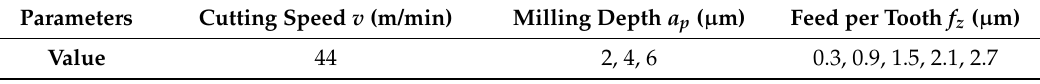
Table 2. Micromilling parameters.